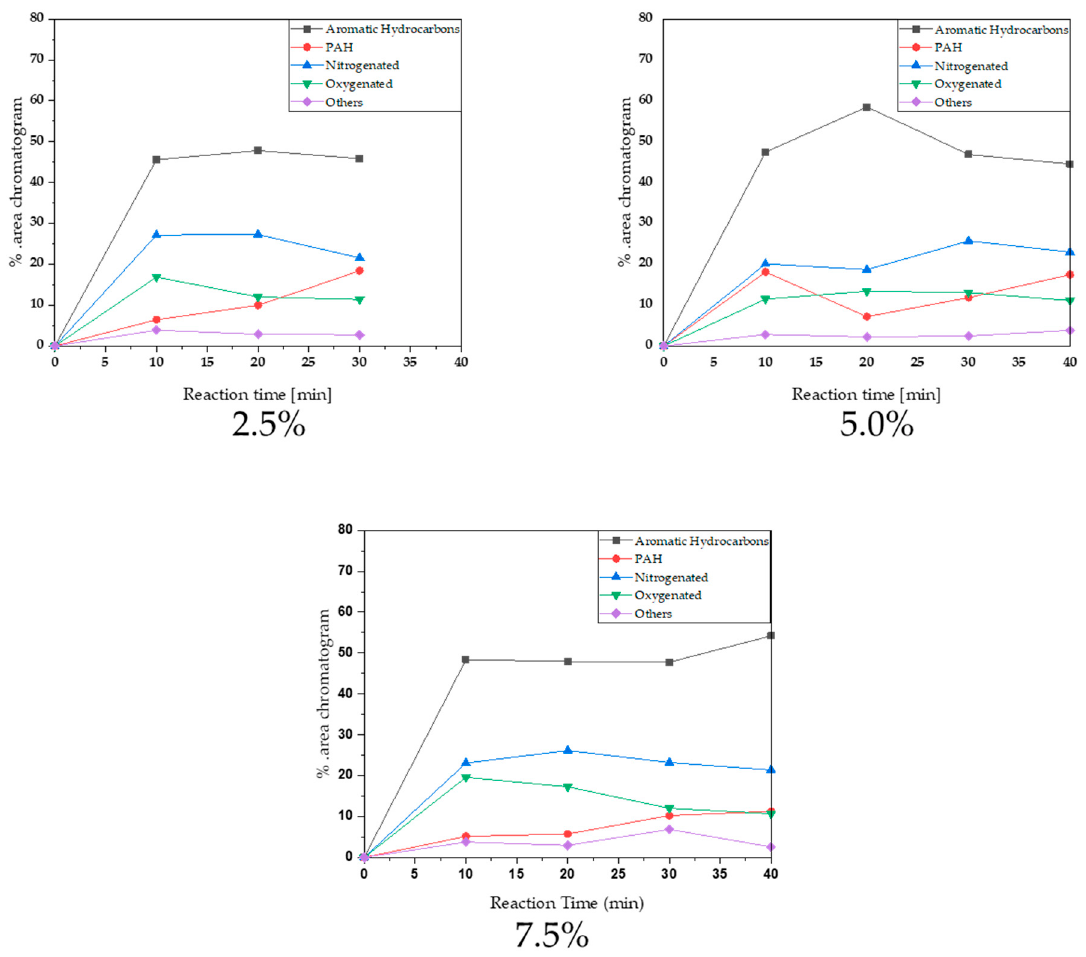
Figure 17. Reaction time effect on chemical composition of bio-oil obtained through catalytic up- grading of WEEE plastic at 450 °C, over 2.5, 5.0, and 7.5%